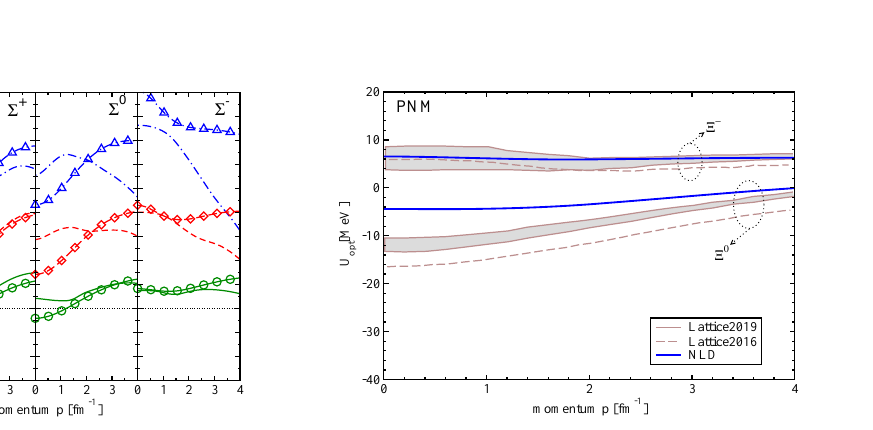
Figure 7. Same as in Fig. 6, but for pure neutron matter (PNM). The curves and bands belonging to Ξ − and Ξ 0 are indicated in this figure.